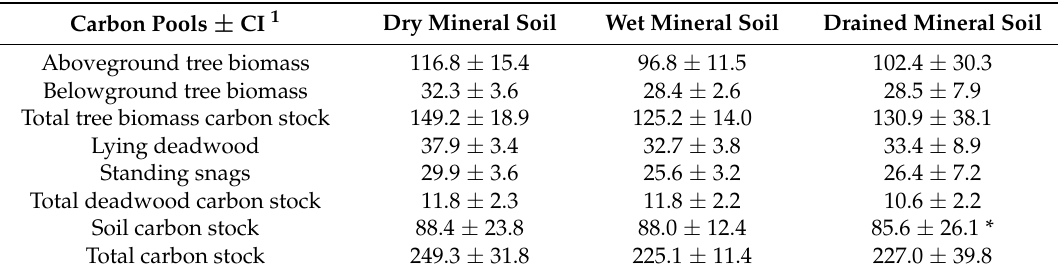
Table 2. Mean carbon stock (Mg C ha − 1 ) of live, dead trees and soil in over-mature spruce forests between the different forest site